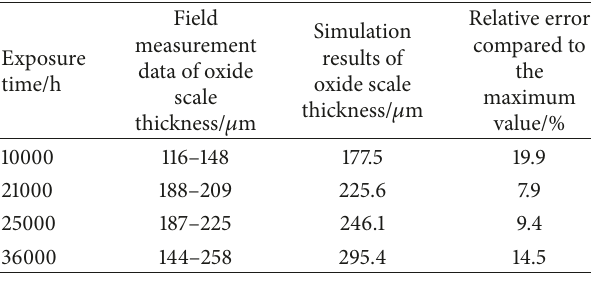
Figure 8: A cross-sectional SEM image of the oxide layer formed on T91 used in a superheater tube for 25000